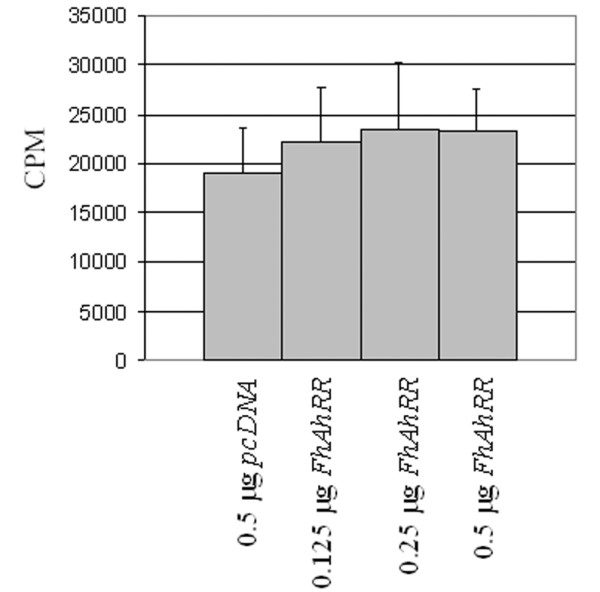
Aryl hydrocarbon receptor repressor does not inhibit proliferation of Hs578T breast cancer cells. Hs578T cells were transfected with control pcDNA vector or with FhAhRR plasmid as in Figure 4, plated in triplicate in 96-well plates, and allowed to adhere overnight before addition of 3H-thymidine. Cells were harvested 18 hours later and assayed for 3H-thymidine incorporation. Triplicates were averaged in each experiment. Data are pooled from three experiments and are presented as the mean counts per minute (CPM) + standard error. There were no statistical differences between groups.